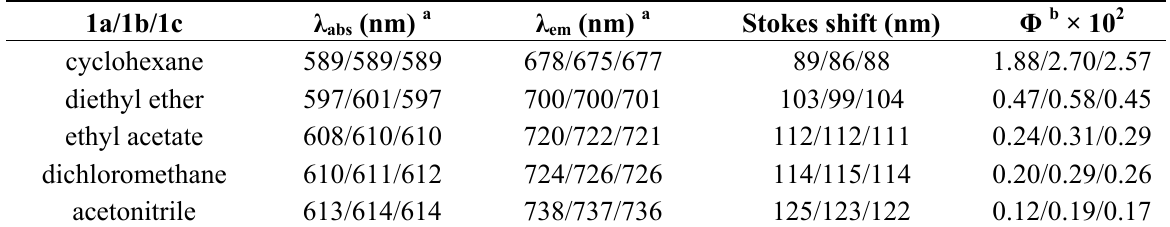
Table 1. Summary of optical absorption and emission properties of 1a – 1c in various